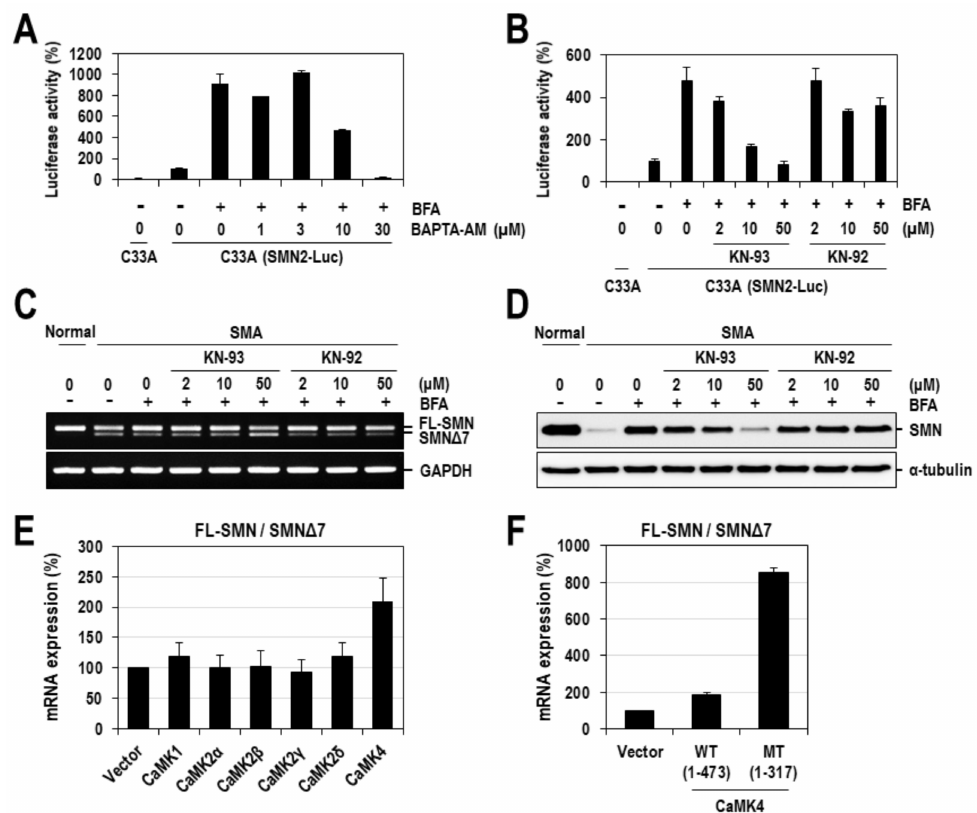
Figure 5. BFA-induced exon 7 inclusion is regulated by intracellular calcium and CaMKs. ( A ) Effect of BAPTA, a repre- sentative calcium chelator, on the alternative splicing of SMN2 exon 7 in C33A cells. SMN2-Luc cells were treated with various concentrations of BAPTA-AM in the presence of BFA (1 µ M) for 24 h and then assayed for the firefly luciferase activity. Relative luciferase activities were calculated by normalizing to that from DMSO-treated cells and presented as a percentage. The mean values and standard deviation were determined from two independent experiments. ( B ) The effect of CaMK-specific inhibitor KN-93 and its inactive analog KN-92 on SMN2 splicing reporter cells. The mean values and standard deviation were determined from two independent experiments. ( C ) SMA fibroblasts were treated with the indicated concentrations of KN-93 or KN-92, along with BFA (1 µ M) for 24 h, and then the total RNAs were prepared and subjected to RT-PCR for the analysis of exon 7 inclusion/exclusion of SMN2 mRNAs. GAPDH mRNAs were also analyzed as a control. ( D ) Lysates from cells used in panel c were harvested and subjected to Western blotting with anti-SMN antibody. α -tubulin was also analyzed as a loading control. ( E ) CaMK4 regulates the alternative splicing of SMN2 exon 7. The effect of CaMK4 on the SMN2-Luc splicing reporter. Various CaMKs (1, 2 α , 2 β , 2 γ , 2 δ or 4) were co-expressed with the SMN2-Luc splicing reporter in 293T cells for 48 h, and then total RNAs were prepared and subjected to RT-PCR analysis of exon 7 inclusion/exclusion. PCR products were quantified using ImageJ software, and the ratio of exon 7-included/-excluded (FL-SMN/SMN ∆ 7) mRNAs were calculated. Each value was normalized to the value from empty vector-transfected cells and presented as a percentage. The mean values and standard deviation were determined from three independent experiments. ( F ) Effect of a constitutively active form of CaMK4 on the SMN2-Luc splicing reporter. The experimental procedure was the same as in panel ( E